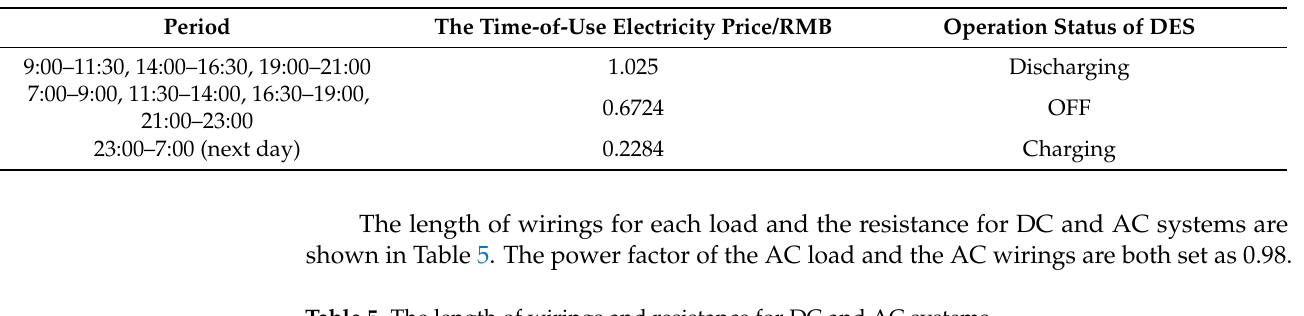
Table 5. The length of wirings and resistance for DC and AC systems.